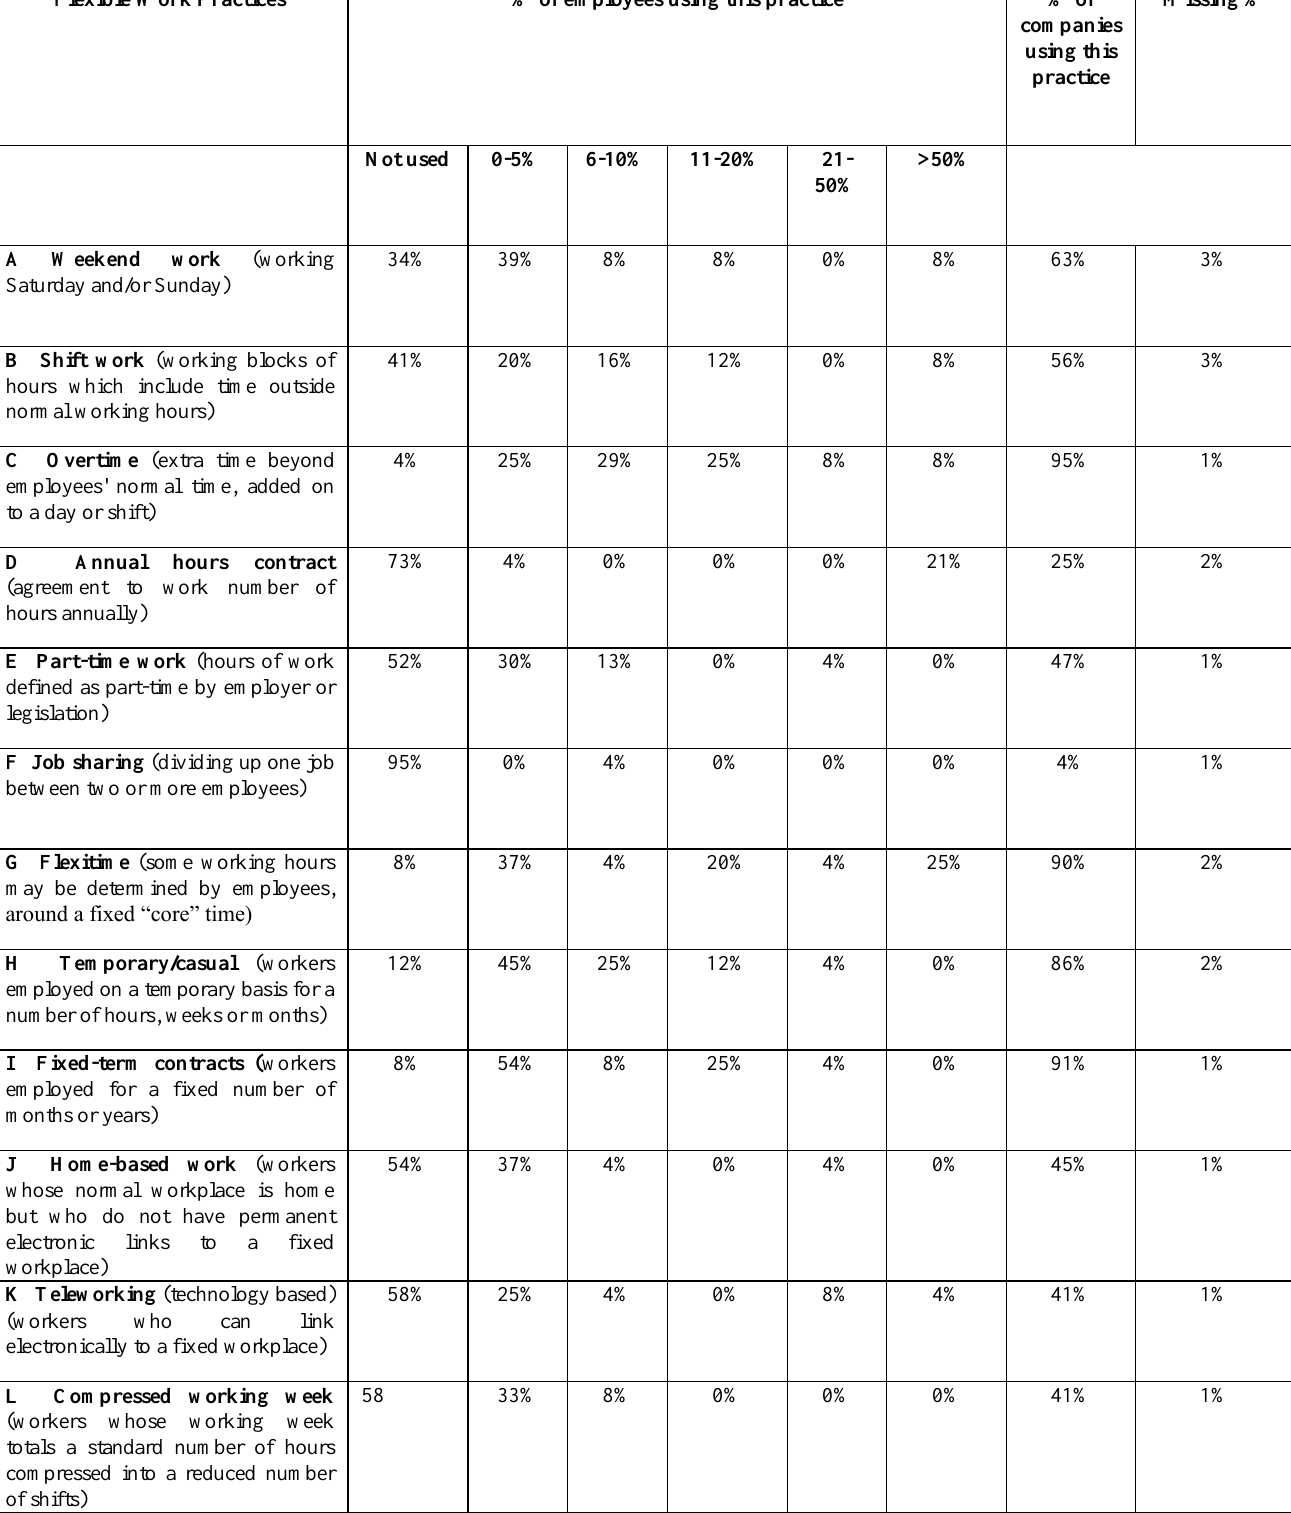
Table 6: Flexible work practices used by the companies listed on the JSE Flexible Work Practices % of employees using this practice % of